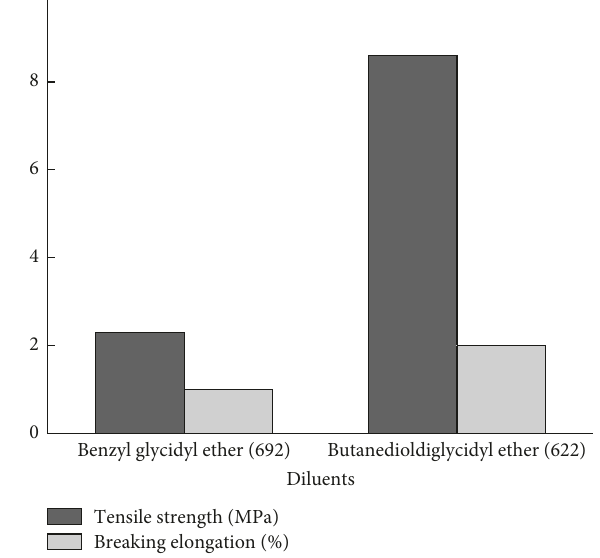
Figure 5: Effect of different diluents on tensile properties. Table 3: Effect of different ratios of Component A/diluent on tensile properties after 7 days.